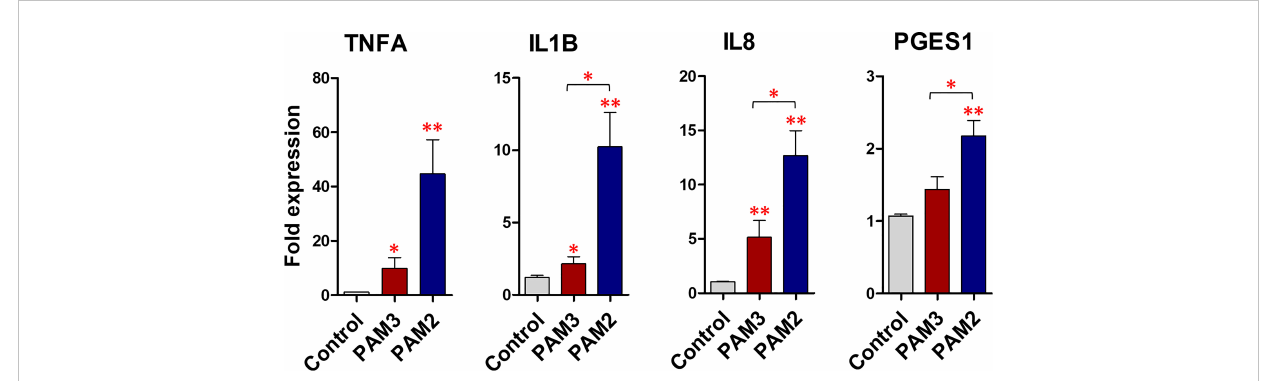
FIGURE 3 PAM3 and PAM2 induce a weak and strong in fl ammatory response, respectively, in BEECs. The relative mRNA expression of pro-in fl ammatory cytokines and PGES1 , after stimulation with 100 ng/mL PAM2 and PAM3 for 1h. This experiment was repeated seven times using epithelial cells from seven different uteri. Asterisks show a signi fi cance of difference (*P < 0.05 or **P < 0.01, Mann – Whitney test).